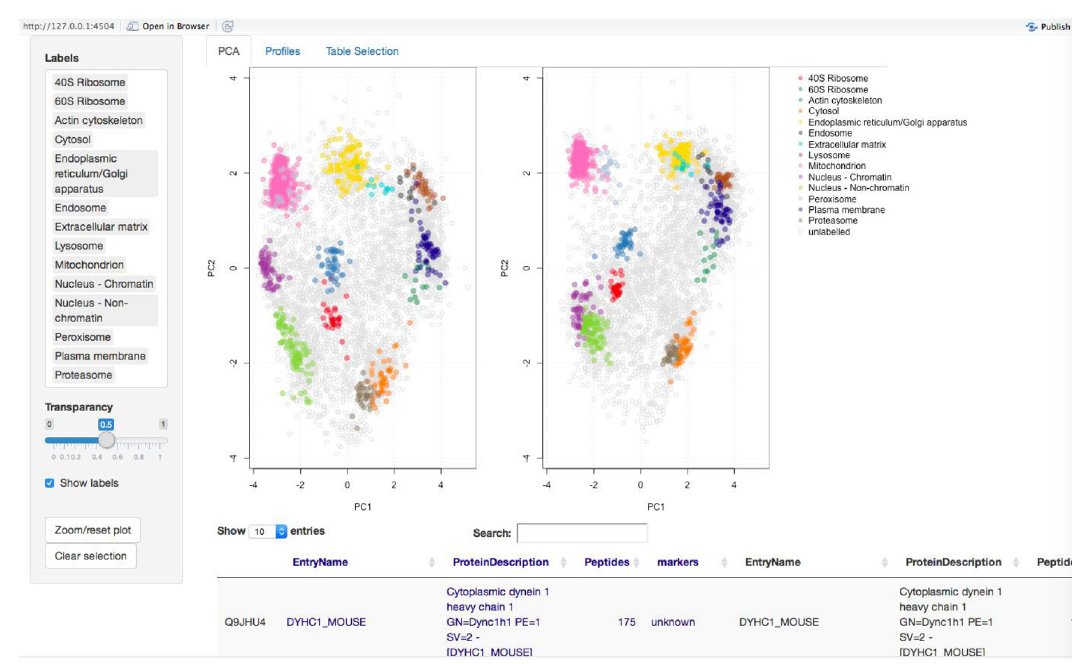
Figure 13. The compare application, main panel.